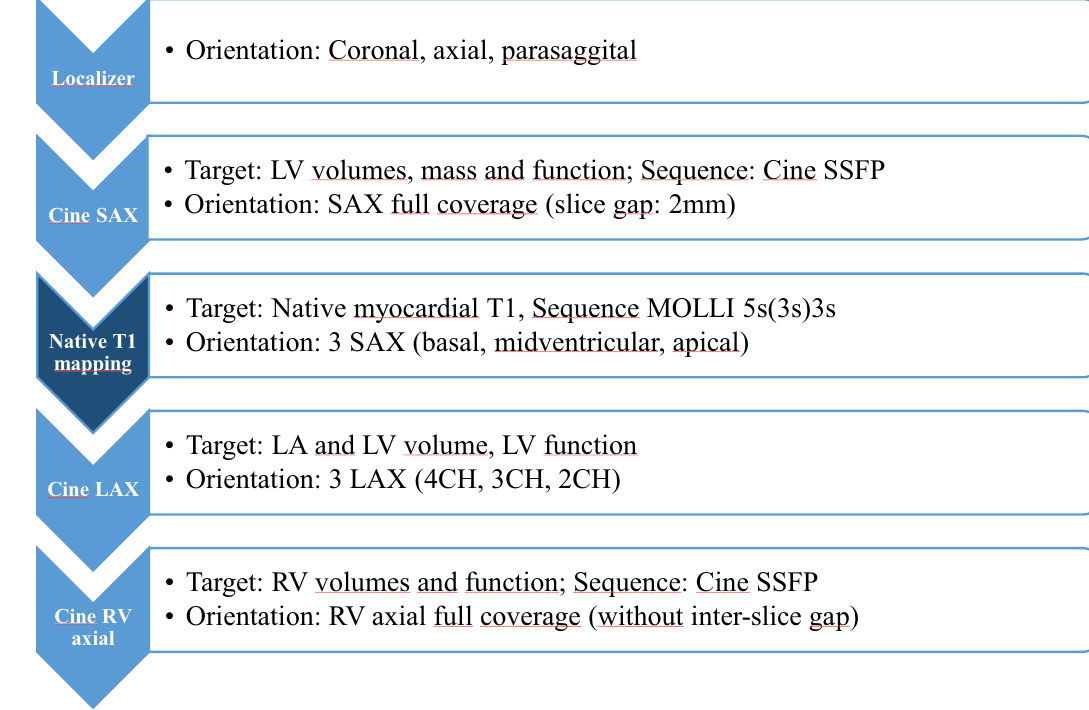
Figure 3. CMR protocol. Abbreviations : LAX = long axis view, LGE = late gadolinium enhancement, MOLLI = modified Look-Locker inversion recovery, SSFP = steady state free precession, 4CH = 4 chamber view, 3CH = 3 chamber view, 2CH = 2 chamber